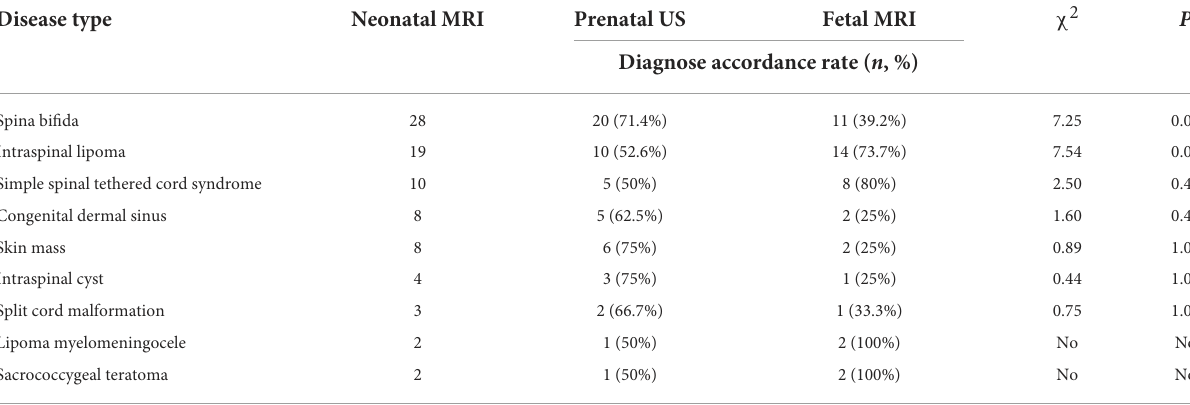
TABLE 2 Comparative analysis data of the diagnostic coincidence rates of prenatal ultrasound (US) and fetal magnetic resonance imaging (MRI) for different types of spinal neural tube defects. Disease type Neonatal